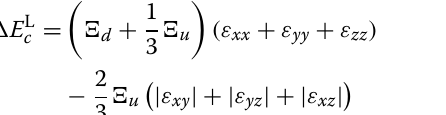
where a c denotes hydrostatic deformation potential with the value of − 8.24 eV at the (cid:2) -point [27], ε xx , ε yy and ε zz are the strain in x , y, and z direction in the mate- rial coordinate system, respectively. However, the shift of the conduction band at the L-point is subject to both hydrostatic and shear strain [19], given by